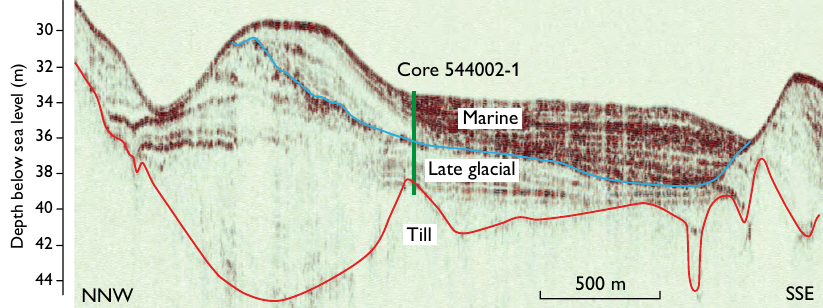
Fig. 4. Selected part of sub-bottom Innomar profile, with the position of sediment core 544002-1 indicated. The red line separates till from late glacial non-marine